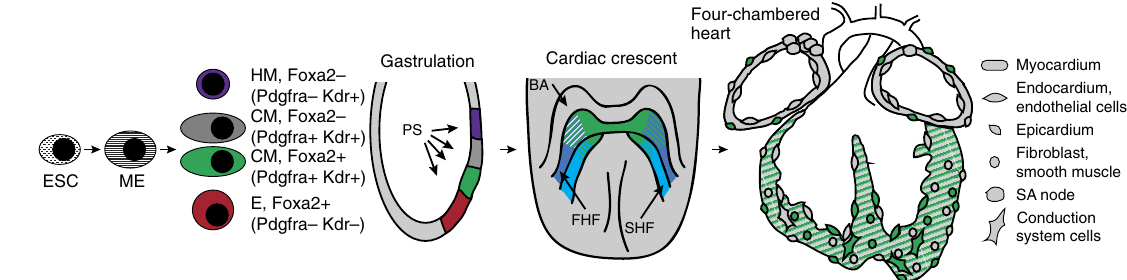
Figure 9 | Schematic illustrating the emergence and subsequent pattern of contribution of Foxa2-vCPs during cardiac development. Foxa2-vCPs (indicated in green) emerge during gastrulation (E6.5–7.5). Progeny derived from the Foxa2-vCPs (continued in green) start expressing the CM markers Pdgfra and Kdr, and migrate to the anterior side of the embryo. In the CC, Foxa2-vCP progeny contribute to both the FHF and SHF, and are located primarily at the apex of the crescent. Finally, in the differentiated four-chambered heart, Foxa2-vCP progeny give rise to cardiomyocytes, endothelial cells and conduction system cells of the left and right ventricular chambers, and to epicardial cells of the entire